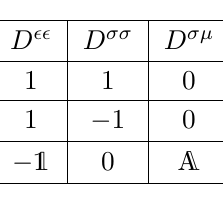
Table 11 . Solutions to the interface sewing constraints for an interface between the standard and fermionic Ising